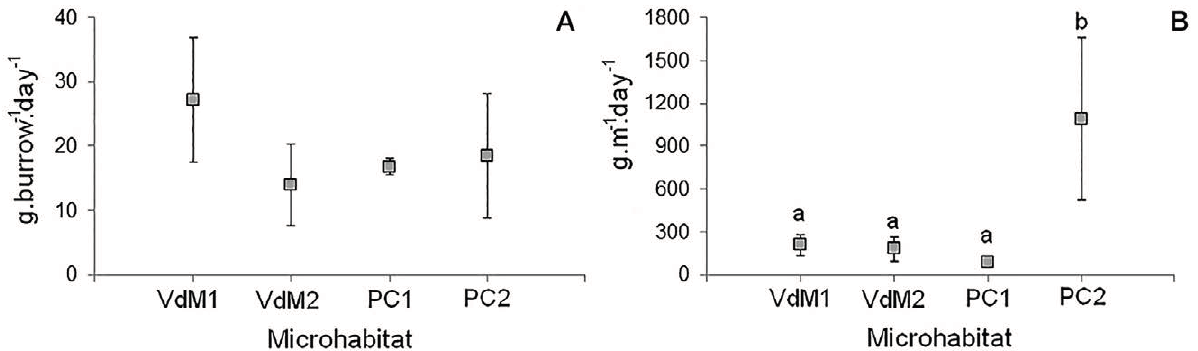
Fig. 5. – Daily dry sediment removal rate. A, of an individual burrow. B, in 1 m 2 , in the different microhabitats. Mean and standard deviation are shown. Tukey test (same letters indicate that there are no significant differences, α =0.05).